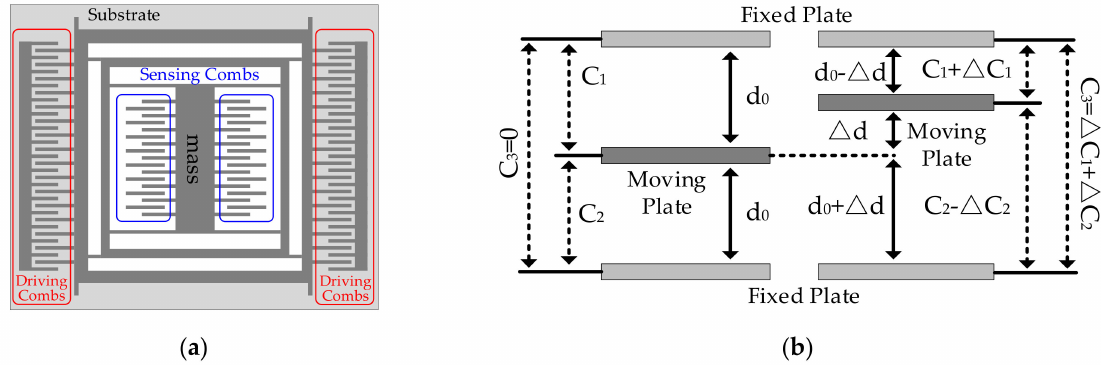
Figure 1. Principle of MEMS accelerometer. ( a ) hardware design; ( b ) system schematic